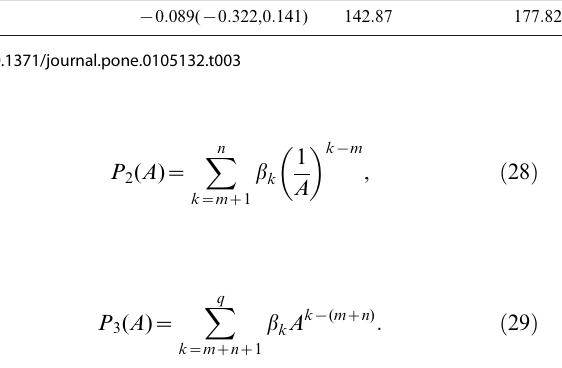
Model Parameter Selection